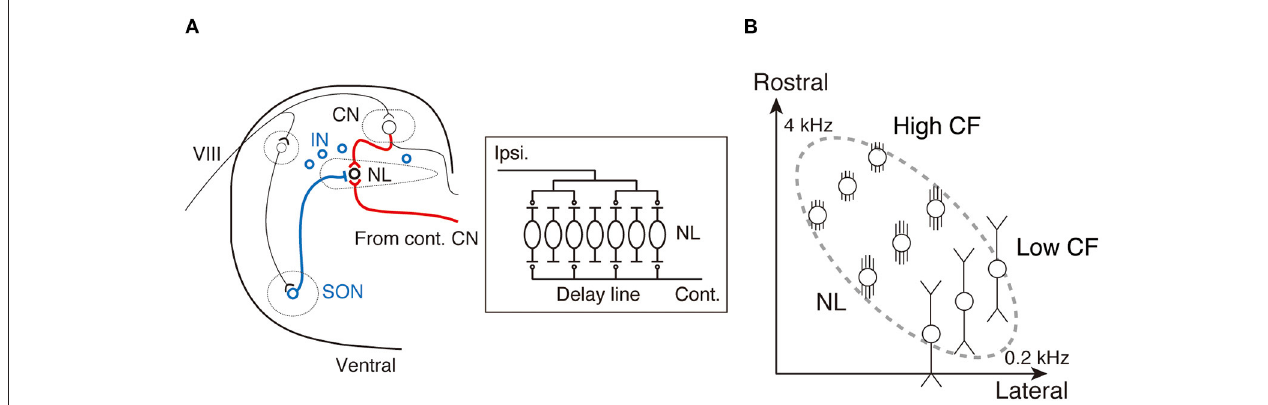
FIGURE 1 | Organization of interaural time difference (ITD) coding circuits in the nucleus laminaris (NL) of the chicken. (A) Brainstem auditory circuit of the chicken. Red lines indicate the excitatory projections from the bilateral CN to the NL. Blue symbols and line indicate inhibitory sources (SON and IN) and projection from the SON to the NL, respectively. A schematic drawing of the ITD coding circuit within the NL is shown in the box (right). CN, cochlear nucleus; IN, interneuron; VIII, auditory nerve; SON, superior olivary nucleus. (B) Tonotopic organization of the